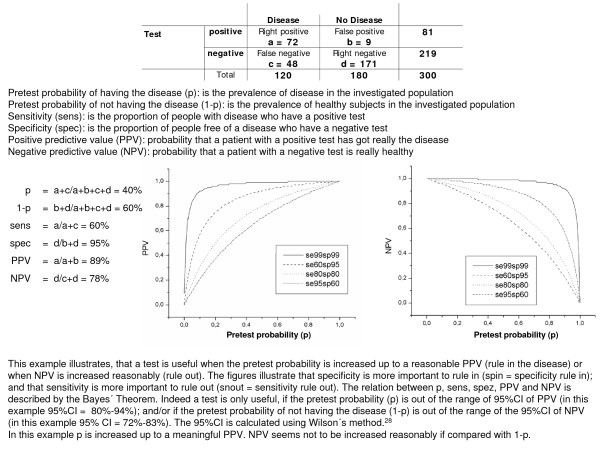
Calculation example for the relation between pretest probability, sensitivitiy, specificity, positive predictive value (PPV) and negative predictive value (NPV).